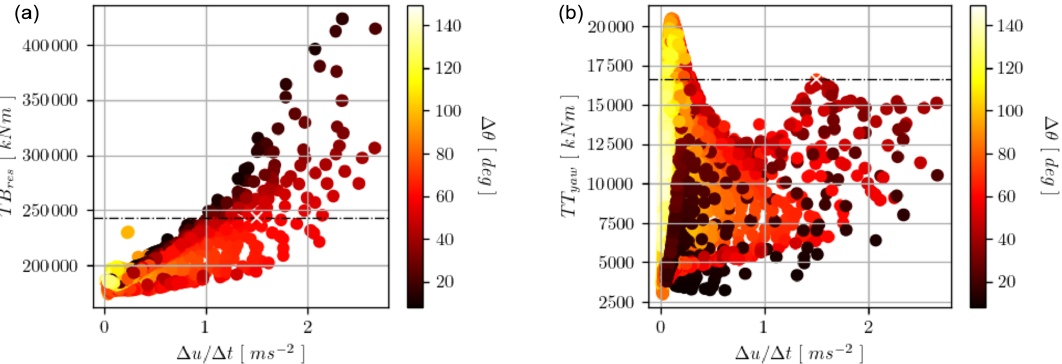
Figure 7. Simulations with yaw control. (a) Tower-base resultant moment as a function of gust acceleration. The colors of the markers refer to the gust directional change in degrees. (b) Tower-top yawing moment as a function of gust acceleration. The marker colors refer to the gust direction change in degrees. The IEC ECD case is marked with a white cross, and its value on the y axis is indicated with the dashed horizontal